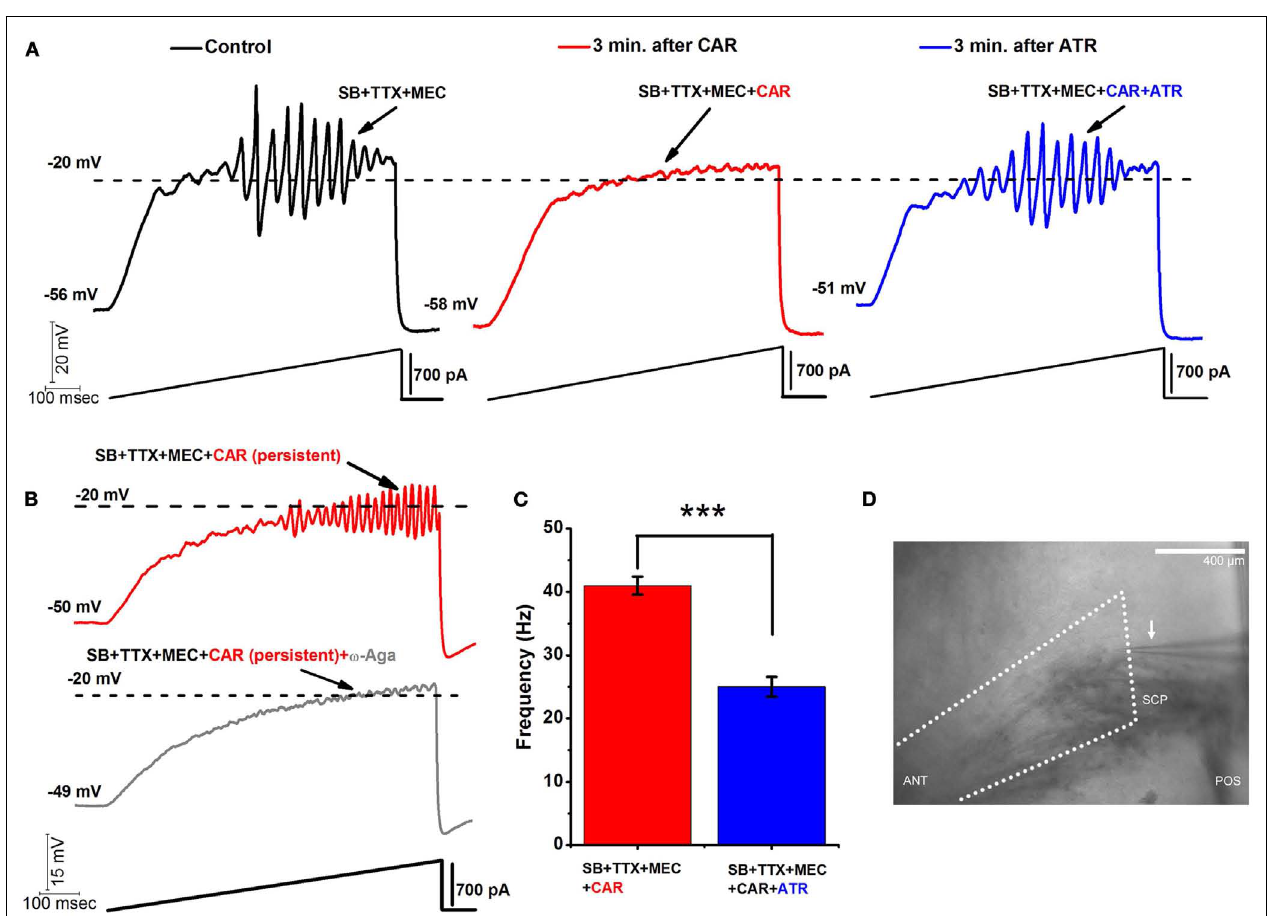
frequency of oscillatory activity in the presence of SB + TTX, the nicotinic receptor blocker MEC, persistent exposure to CAR (red column), and in the presence of SB + TTX + CAR and non-specific cholinergic antagonist ATR (blue column). Note that the mean oscillatory frequency of PPN neurons was significantly higher during persistent exposure to CAR compared to the condition with ATR in the extracellular solution. (D) Wide field photomicrograph of the region of the PPN showing the recording electrode (arrow). Anterior is to the left, posterior to the right, with the fibers of the superior cerebellar peduncle (SCP) visible ventral to the recording pipette within the PPN pars compacta , which is located immediately dorsal to the posterior end of the peduncle.This was the region selectively sampled, and every cell identified as to PPN cell type. [In (C) : *** p < 0.001; calibration bar in (D) : 400 µ m; abbreviations: CAR, carbachol; SB, synaptic blockers;TTX, tetrodotoxin; MEC, mecamylamine; ATR, atropine; ω -Aga,